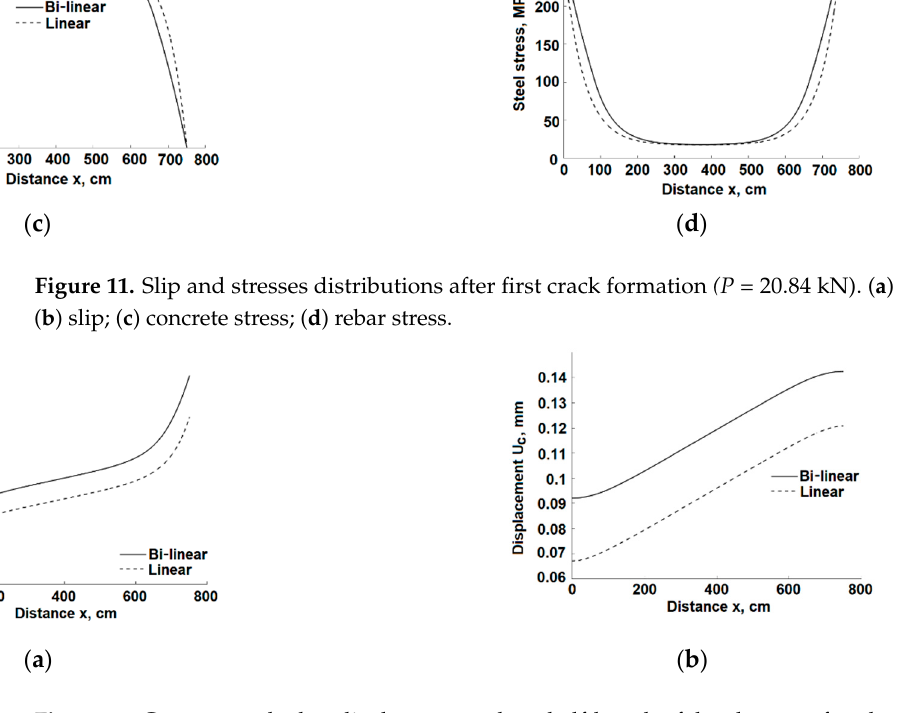
Figure 11. Slip and stresses distributions after first crack formation (P = 20.84 kN). ( a ) bond stress; ( b ) slip; ( c ) concrete stress; ( d ) rebar stress.